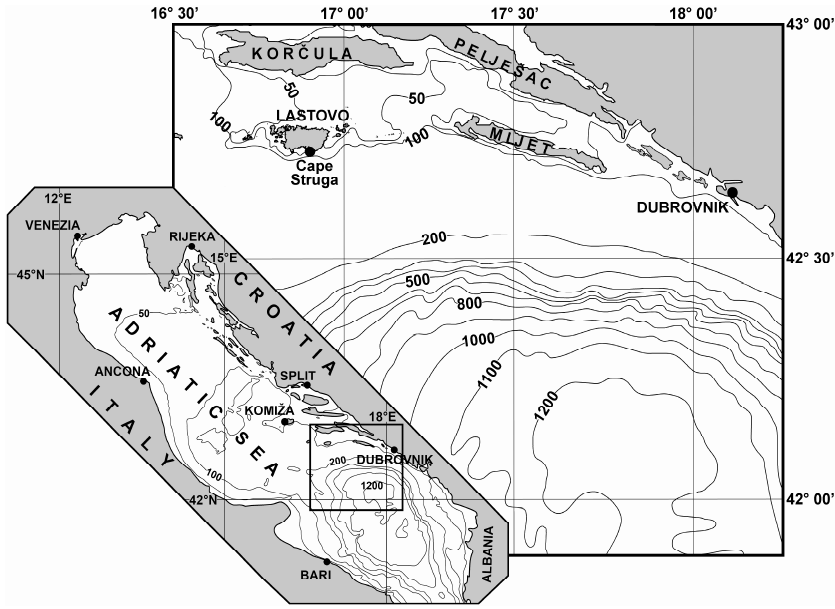
Figure 1. Bathymetry and position of the southeastern part of the Adriatic Sea. The positions of thermistors (Cape Struga) and of the meteorological and tide gauge stations (Dubrovnik) are indicated on the large map. The position of Komiža meteorological station is shown on the small map.